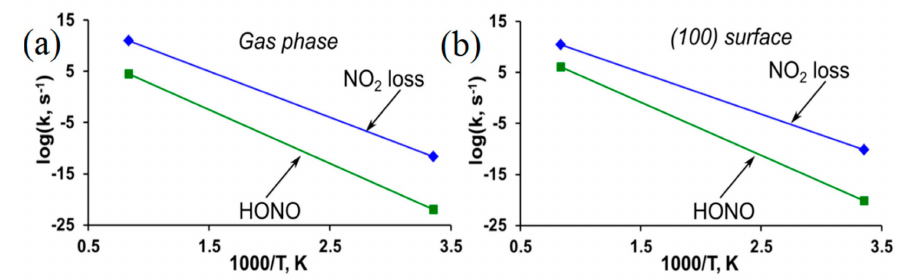
Figure 5. Reaction rates are displayed for the decomposition of β -HMX ( a ) in the gas phase and ( b ) on the (100)